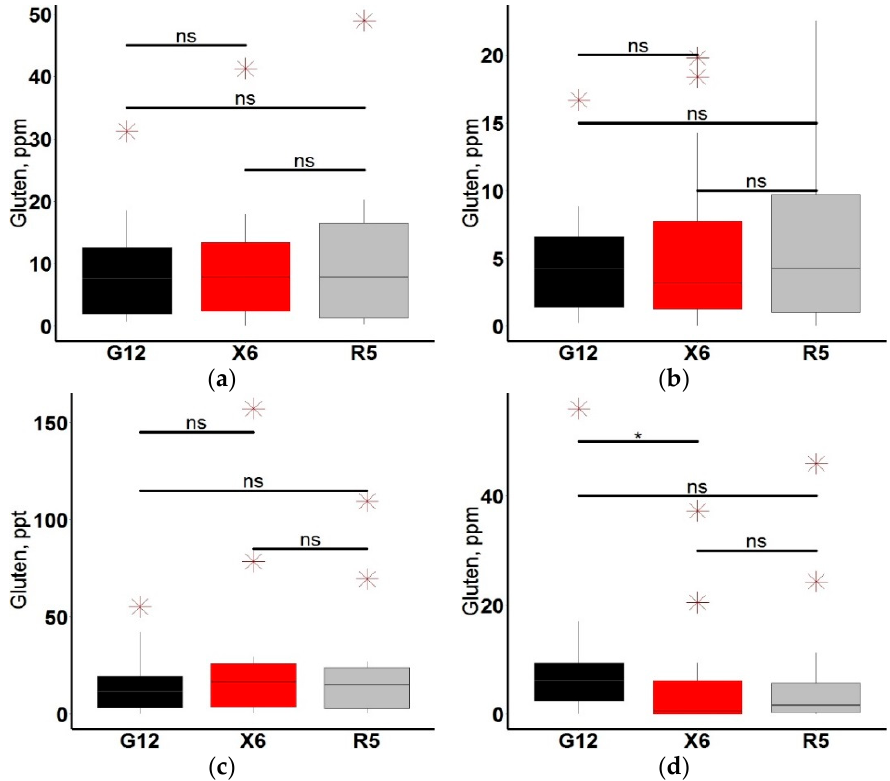
Figure 4. Gluten content in various groups of products: ( a ) bakery ( n = 16), ( b ) flour ( n = 16), ( c ) high–gluten products ( n = 12), ( d ) snack ( n = 18). Outliers are marked with a red asterisk, Mann–Whitney test significance levels are black: ns: p > 0.05; *: p ≤ 0.025.